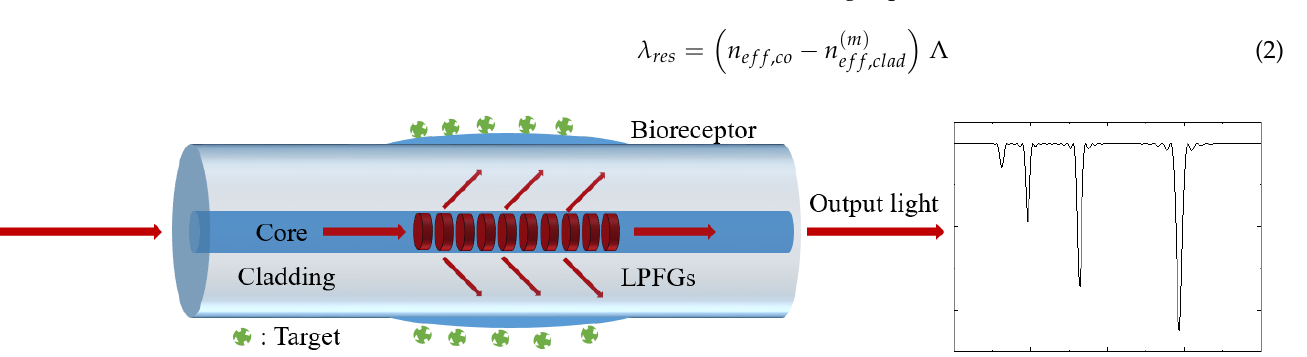
Figure 2. Schematic illustration of OFBS based on an LPFG.